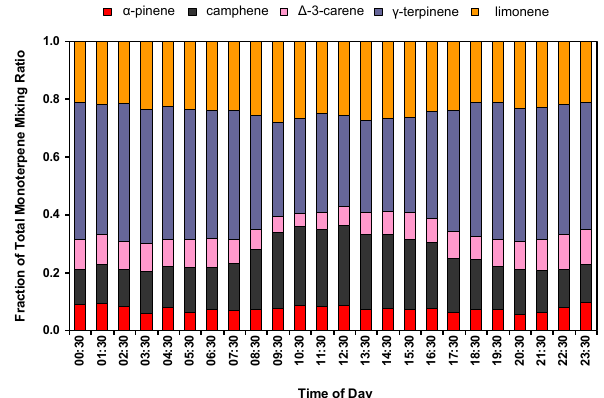
Fig. 6. Average diurnal variation in the relative fractions of the indi- vidual monoterpenes α -pinene (red), camphene (grey), 1 -3-carene (pink), γ -terpinene (blue) and limonene (orange), based upon mea- surements between 23 June–20